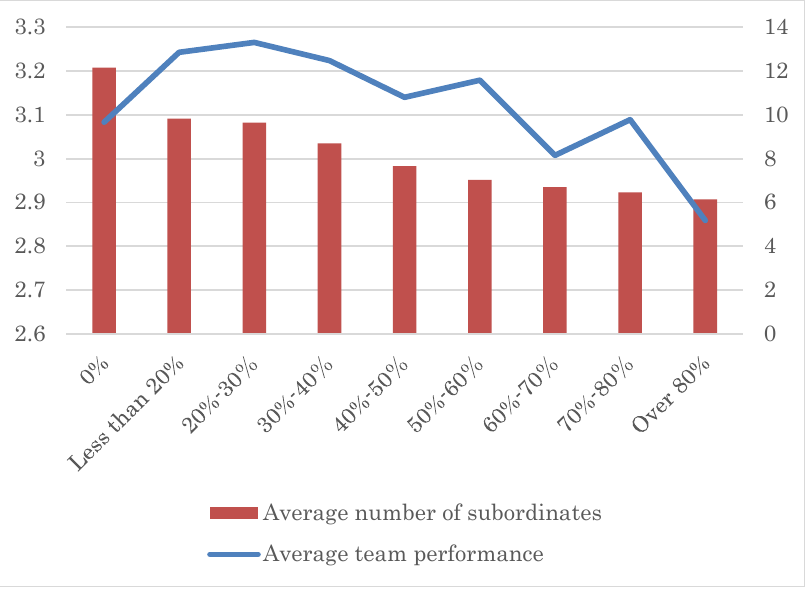
Figure 3. Average team performance and number of